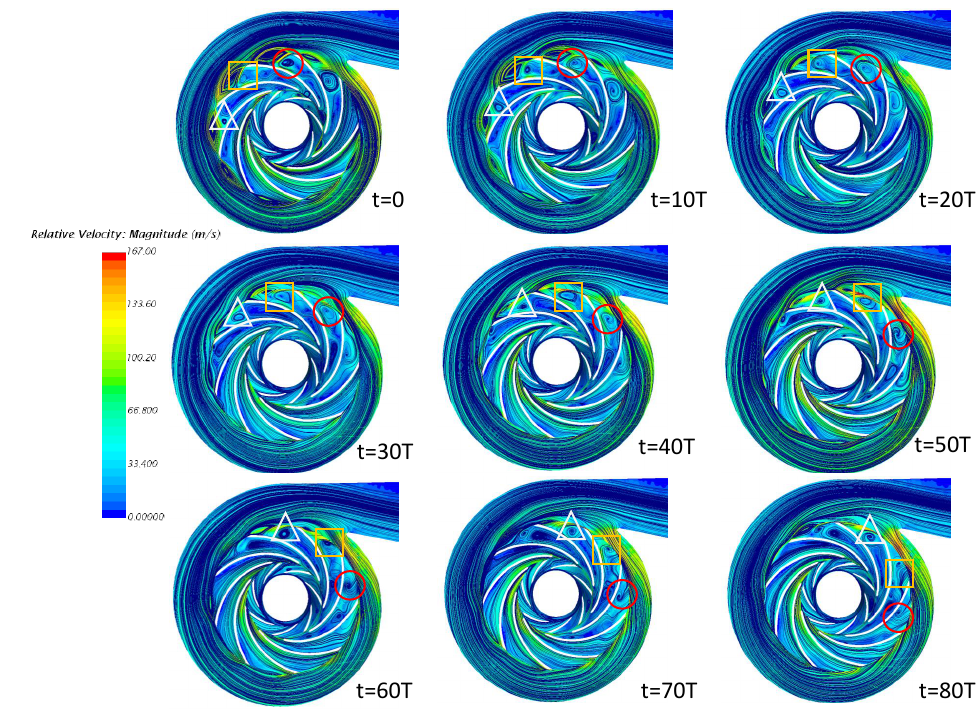
Figure 13. Streamline patterns of different time-step at NSP.